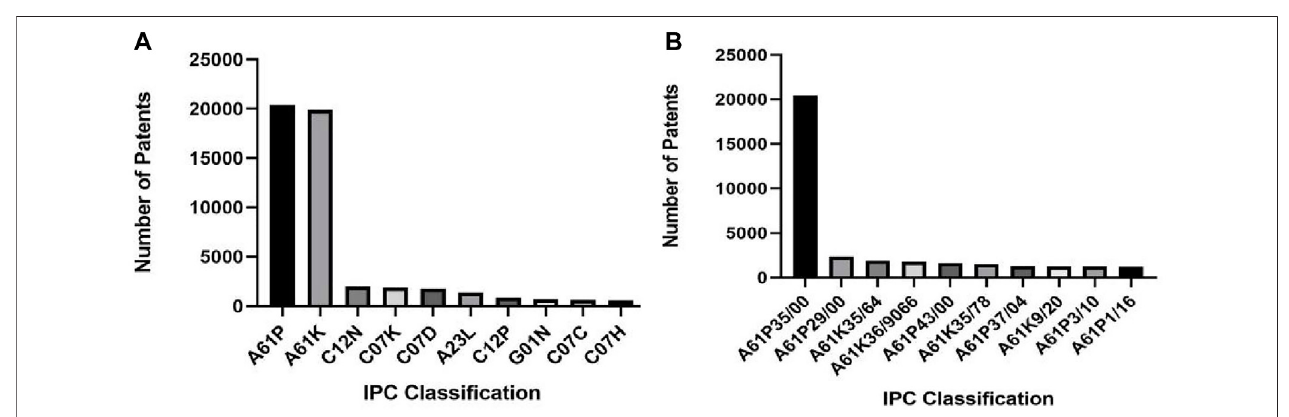
FIGURE 6 | Patented technology distribution of anticancer natural products. The IPC classi fi cation number re fl ects the technical fi eld covered by each patent. (A) Technology distribution on the IPC subclass dimension. Anticancer natural products are mainly distributed in the A61P and A61K subclasses. (B) Technology distribution on IPC group dimension. Anticancer natural products are mainly distributed in the A61P35/00 and A61P29/00 groups.